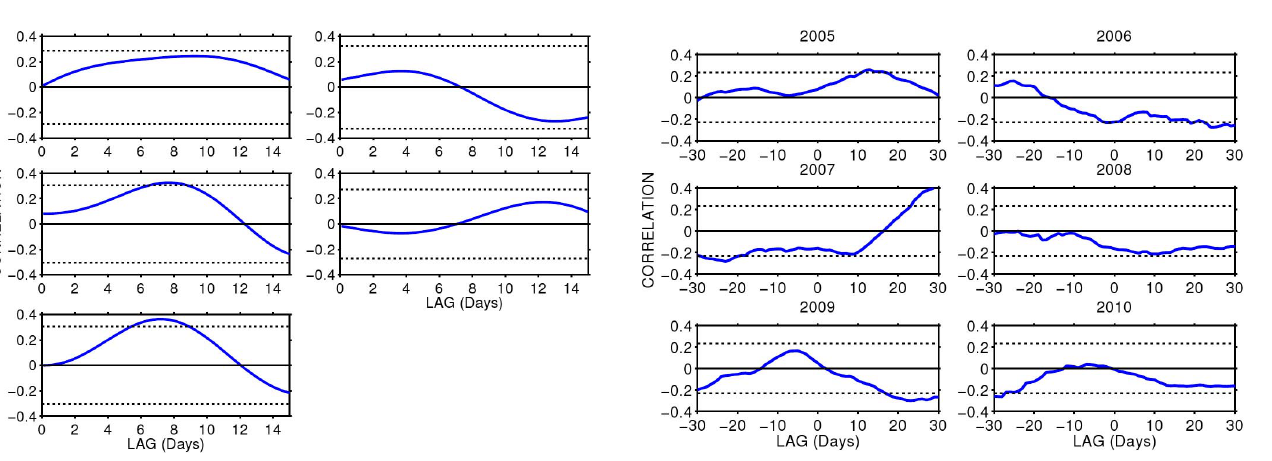
Fig. 17. Correlations (with lags applied to the UFKW zonal wind amplitude) between E1 amplitudes of oscillations with period 2.5– 4.0 days in the tropospheric convective heating and in the amplitude of UFKW in the MLT, for five integrated years of the Kyushu-GCM. The dashed lines on the figures indicate the 95% confidence limits.